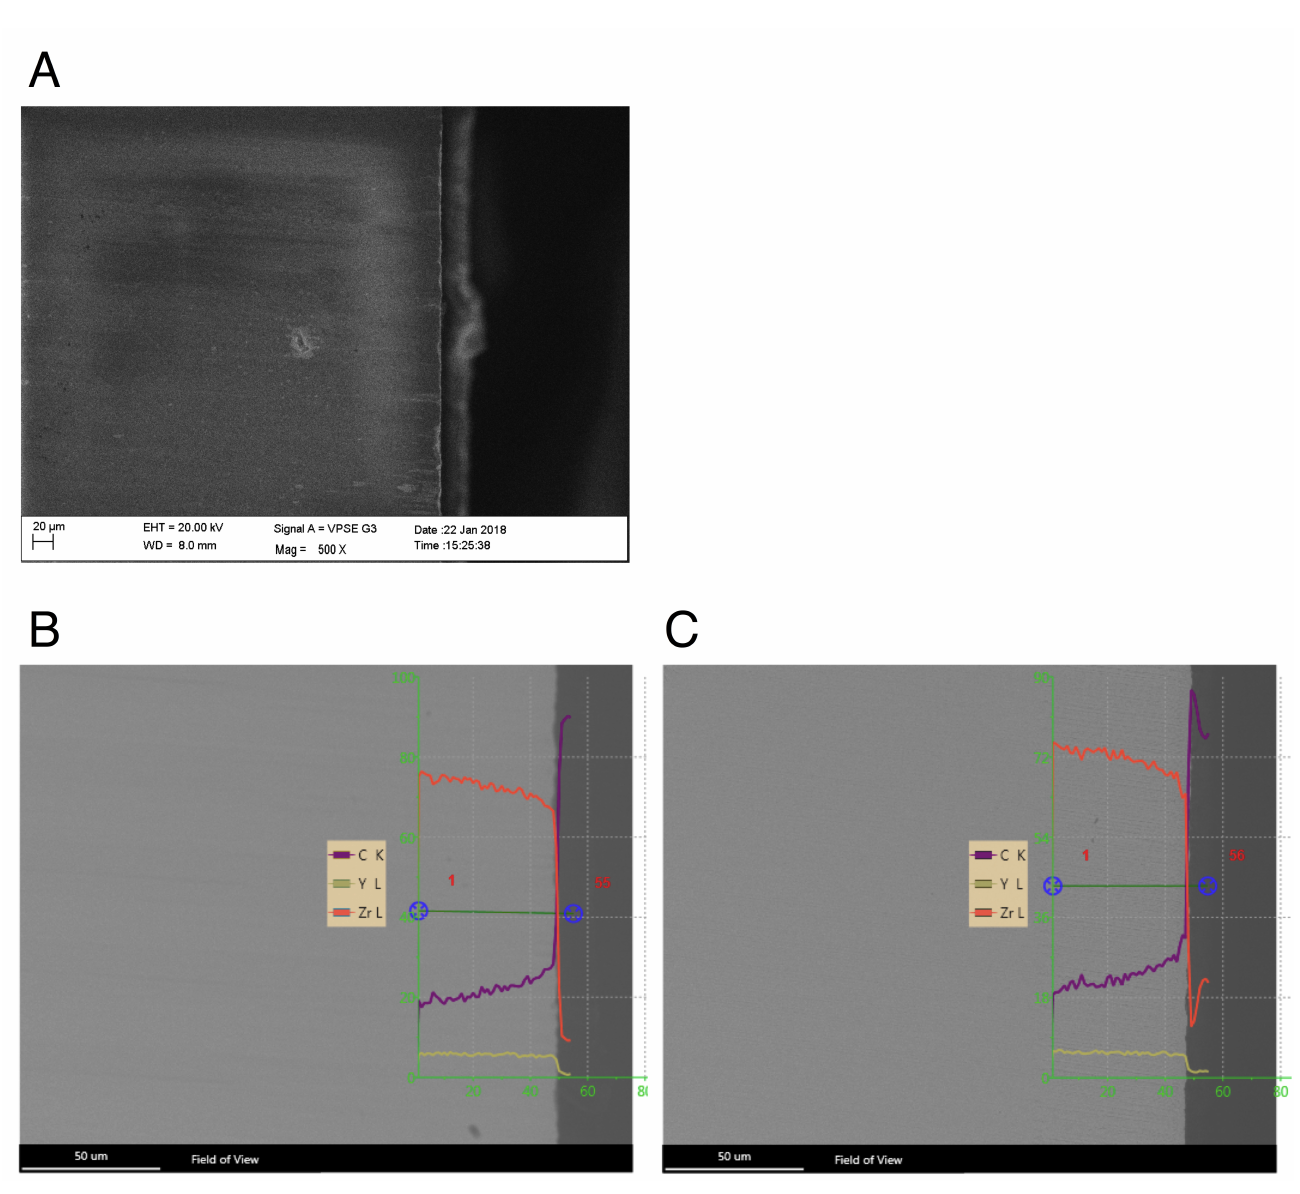
Figure 2. Scanning electron microscope (SEM) and energy-dispersive X-ray spectroscopy (EDS) analysis of specimen slides. ( A ) Detection image of a zirconia specimen in cross section after short-term artificial aging. EDS image of ( B ) A/SU: air abrasion and Scotchbond Universal and ( B ) AP/SU: air abrasion, additional cold atmospheric plasma treatment (CAP), and Scotchbond Universal. ( C ): Carbon, Y: Yttrium and Zr: Zirconium are shown as percentages up to a depth of 50 µ